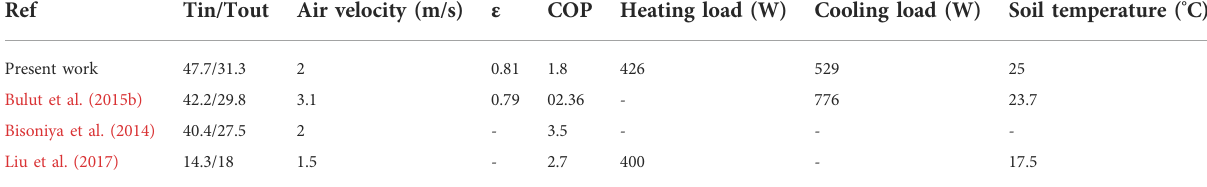
TABLE 3 Results of this work with the results of similar